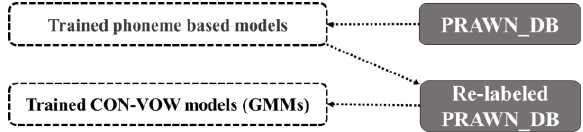
Figure 2. The procedure for constructing two Gaussian Mixture Models (GMMs) (for consonants and vowels) for interval detection.